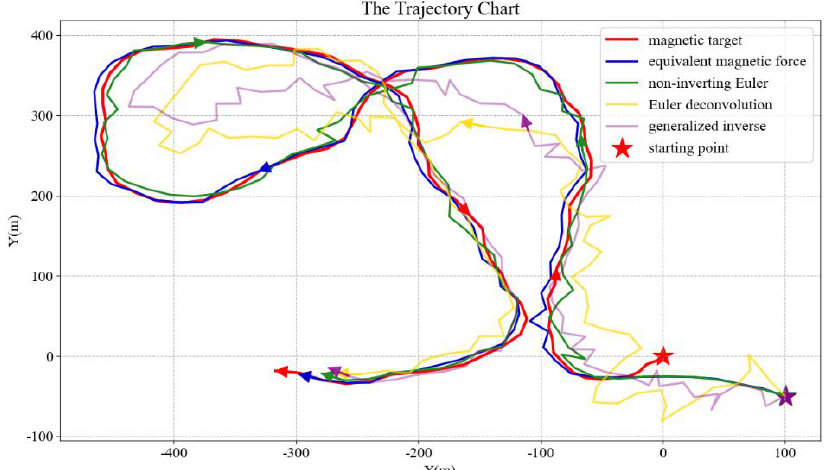
Figure 4. Comparison of tracking performance of various methods. The moving magnetic target generates red tracks, and the other four tracks correspond to the four methods, respectively. The five-pointed star represents the starting point.